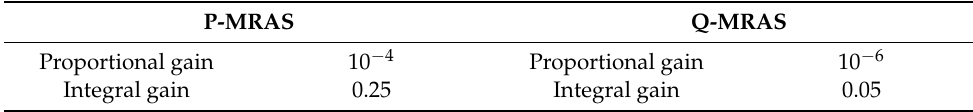
Table A2. P-MRAS and Q-MRAS adaptive PI controller gain